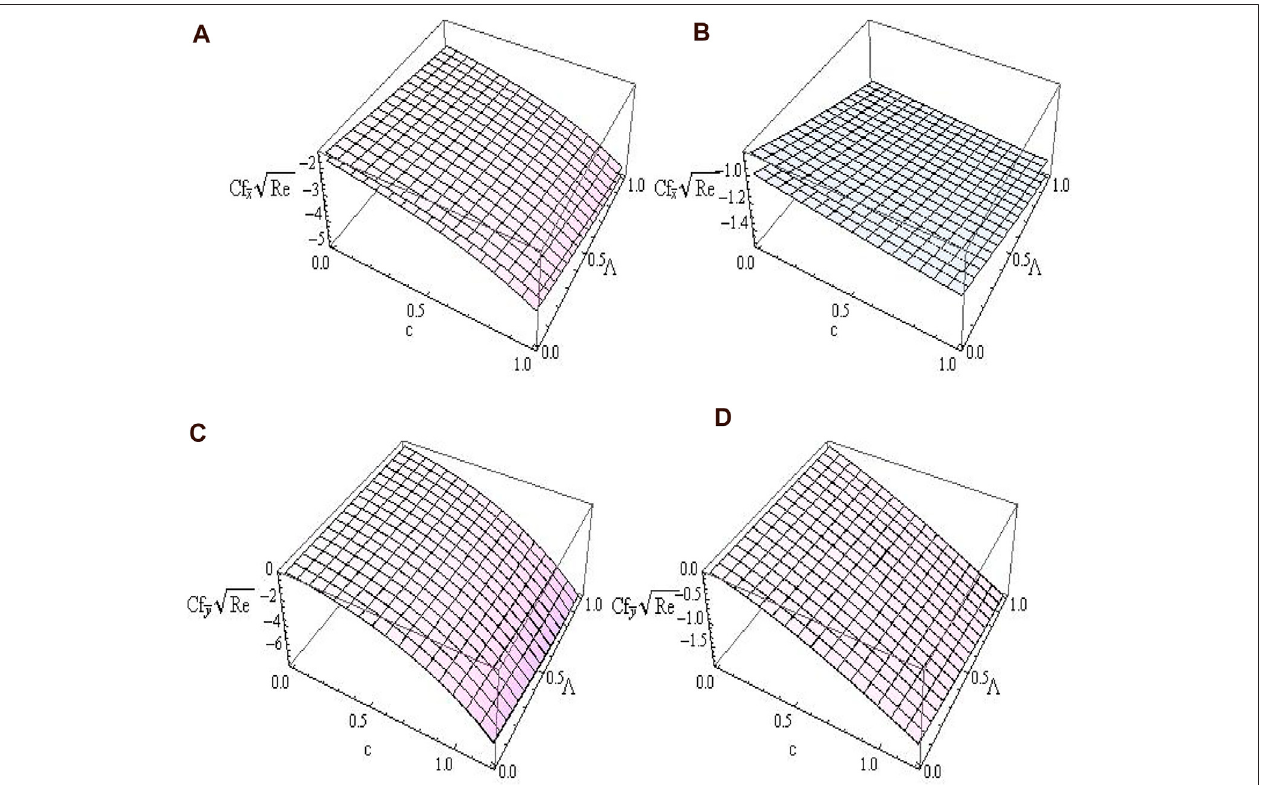
” on cand Λ for (A) upper plateK (cid:1) 0.2, Q (cid:1) 0.3 and lower plate K (cid:1) 0.2, Q (cid:1) 0.0, (B) upper plate K (cid:1) 0.0, Q (cid:1) 0.3 and lower plate FIGURE6 | The variations of “ Cf (cid:1) x ” on c and Λ for (C) lower plate K (cid:1) 0.2, Q (cid:1) 0.3 and upper plate K (cid:1) 0.2, Q (cid:1) 0.0, and (D) lower plate K (cid:1) 0.0, Q (cid:1) 0.3 and upper plate K (cid:1) 0.0, Q K (cid:1) 0.0, Q (cid:1) 0.0, “ Cf (cid:1) y (cid:1)